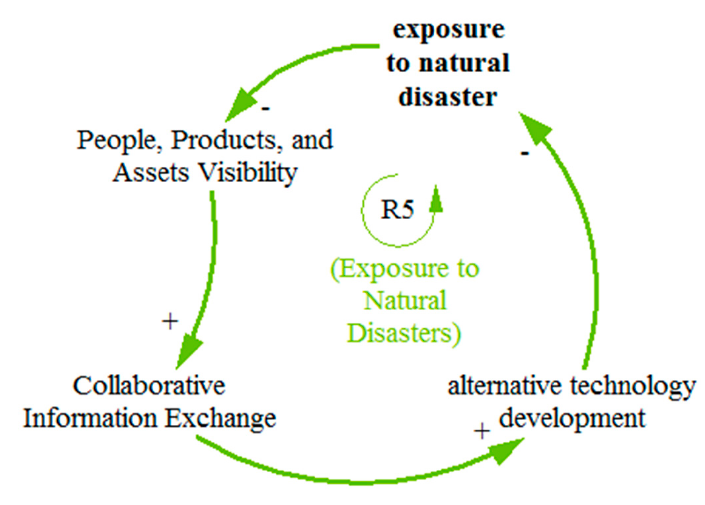
Figure 10. Reinforcing loop R5 (exposure to natural disasters).